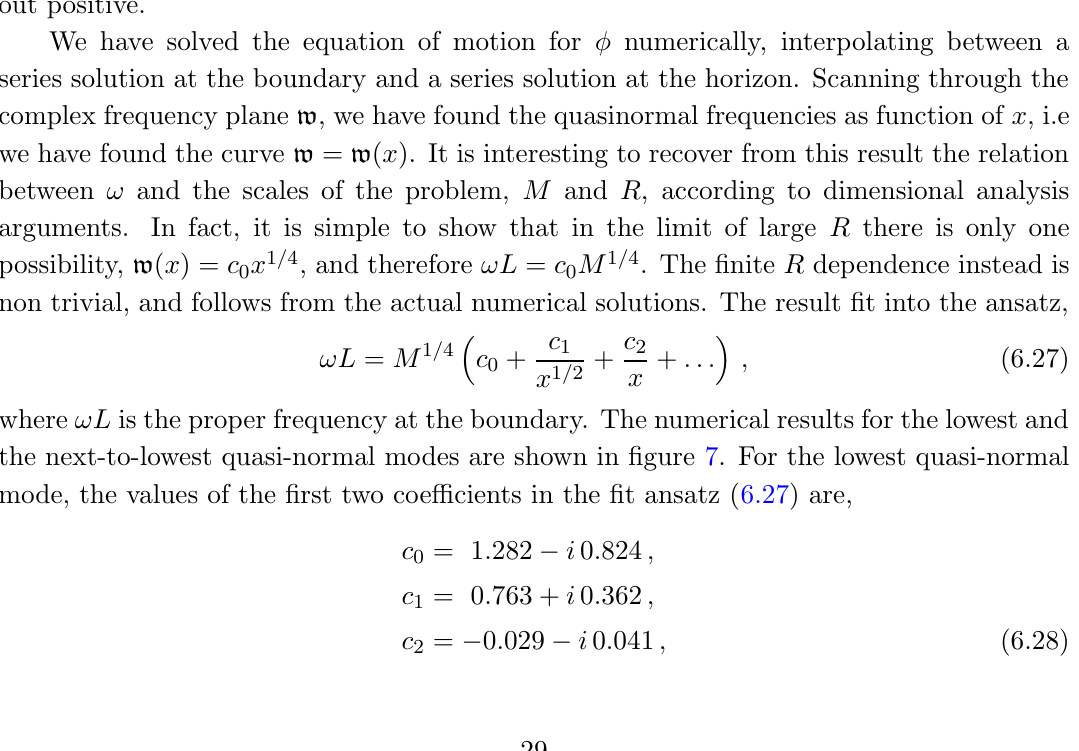
JHEP09(2017)048